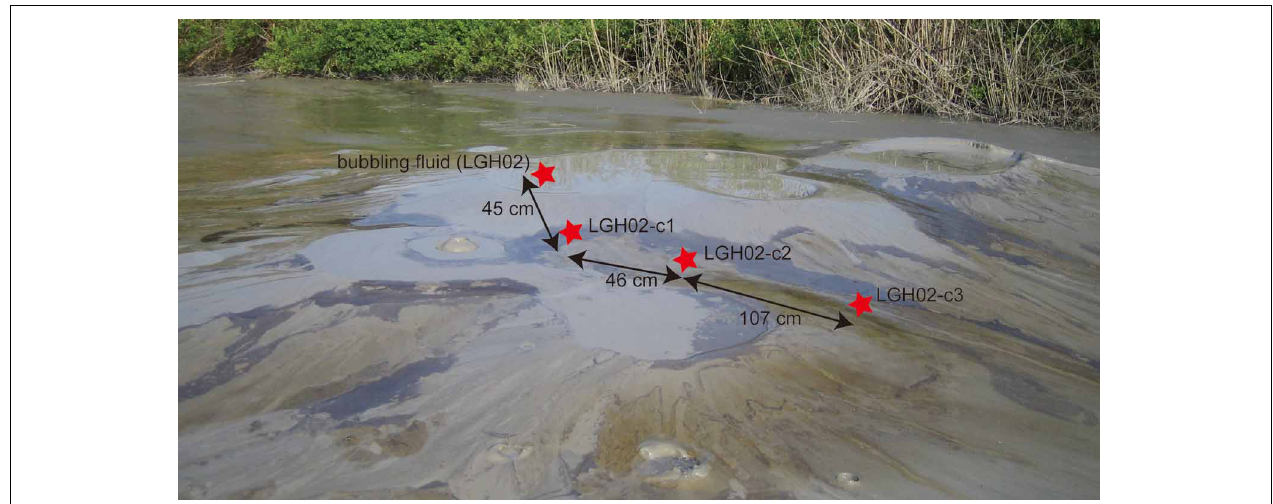
FIGURE 1 | Field photo of the study sites at the LGHMVs in eastern Taiwan. The investigated area is located in the topographic high where a cluster of at least six bubbling pools formed. Bubbling fluids from pool LGH02